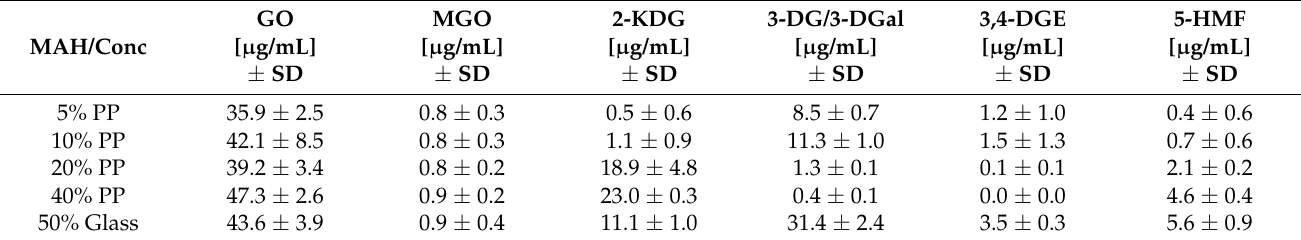
Table 7. Concentrations of GDPs. Manufacturer A ( n =